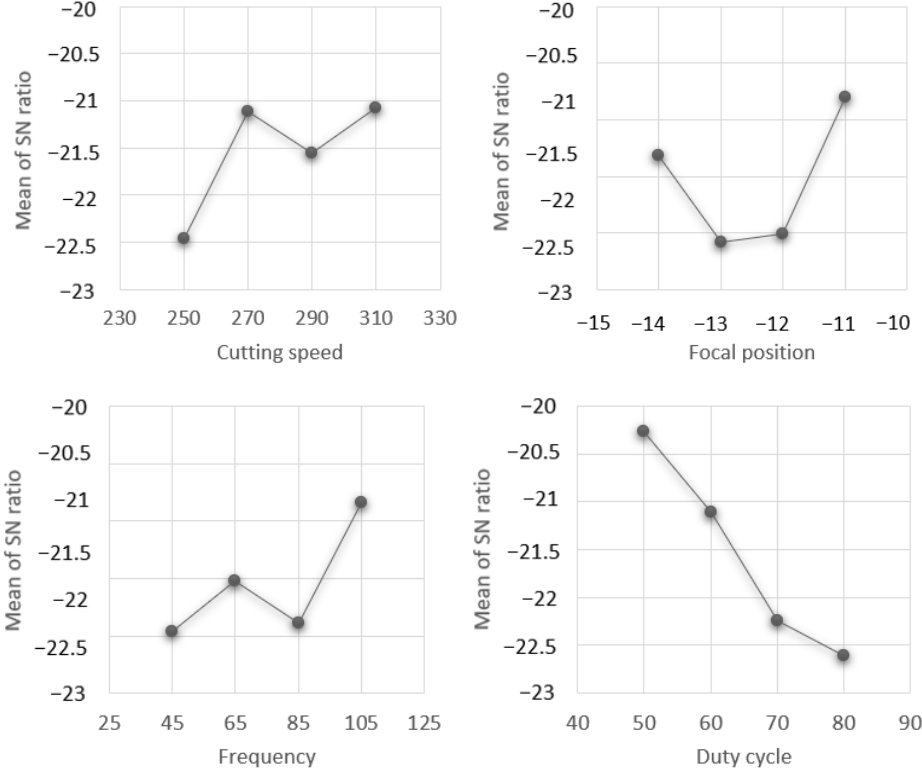
Figure 1. S/N ratios plot effects for the responses of surface roughness .